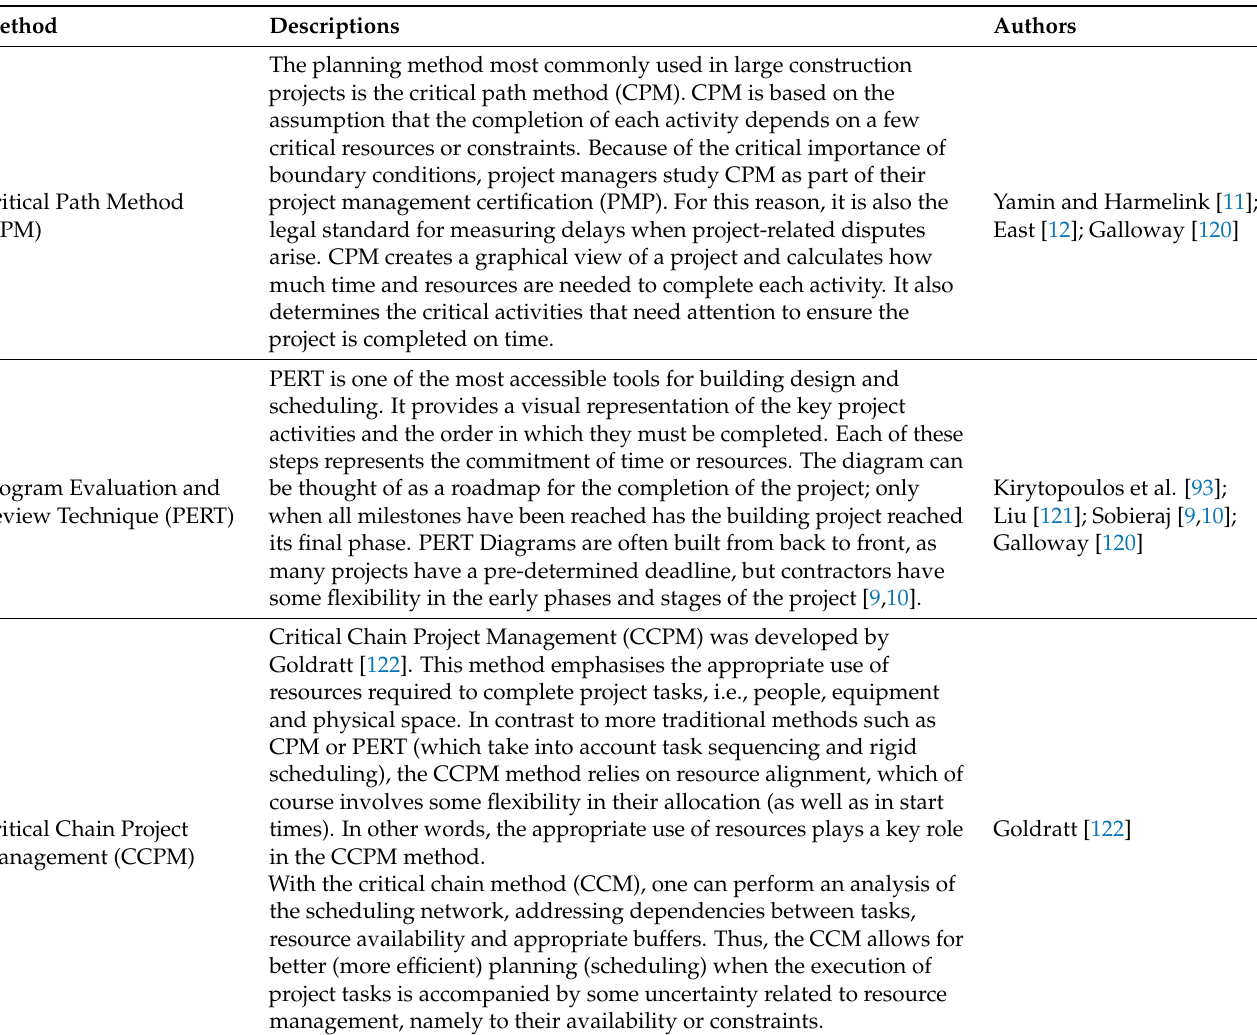
Table A2. Different schedule management techniques—practitioners’